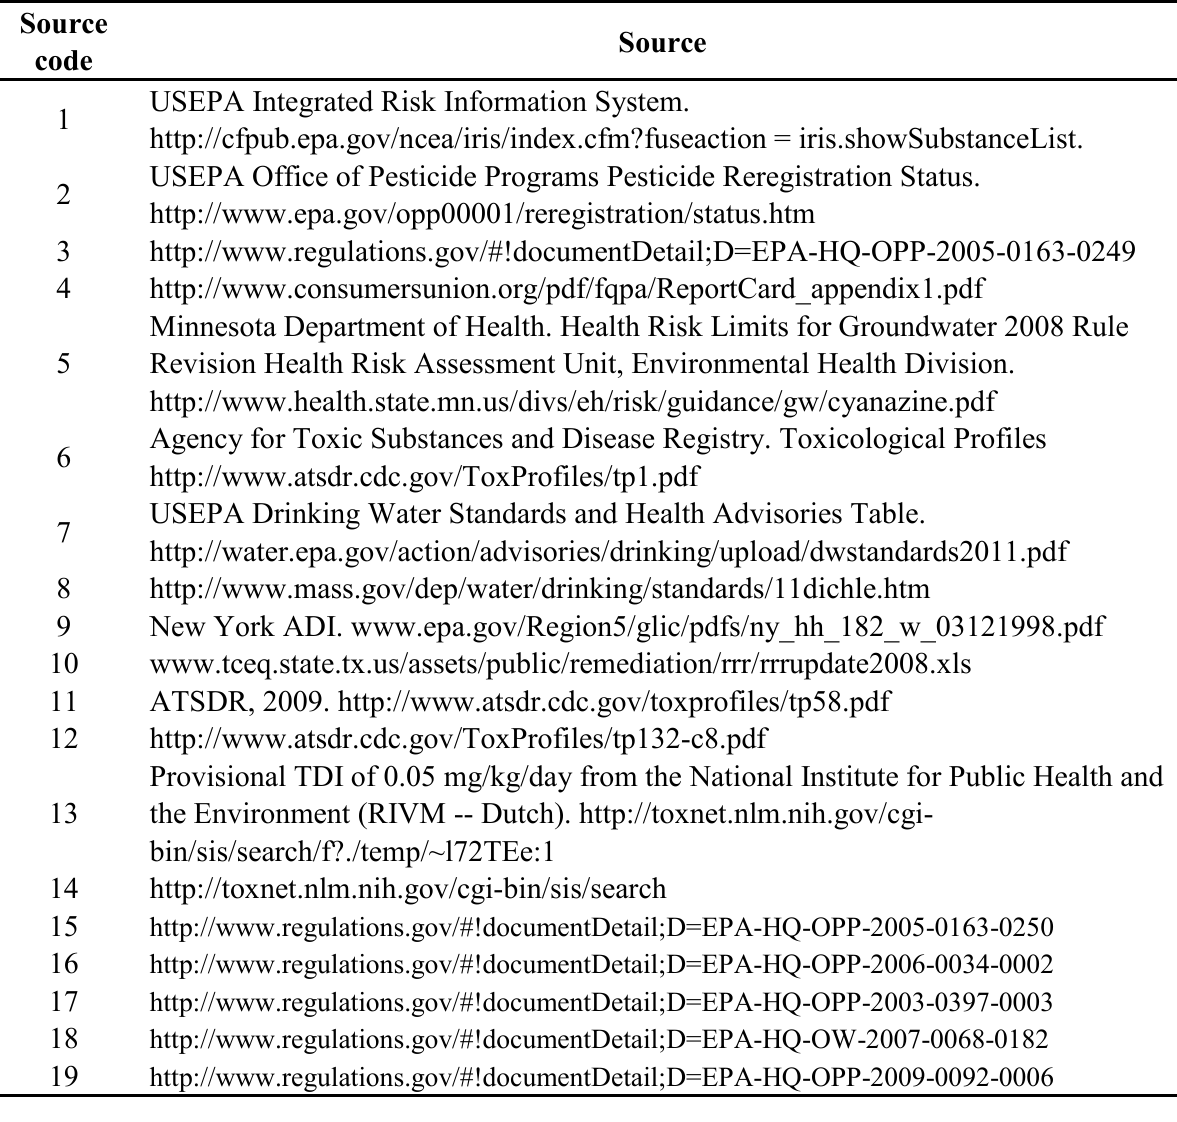
Table 4. Sources of permitted doses used in this study.